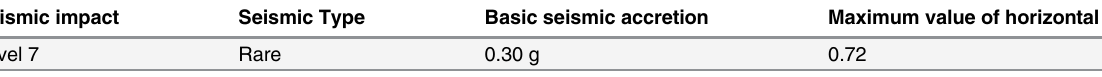
Table 5. Seismic